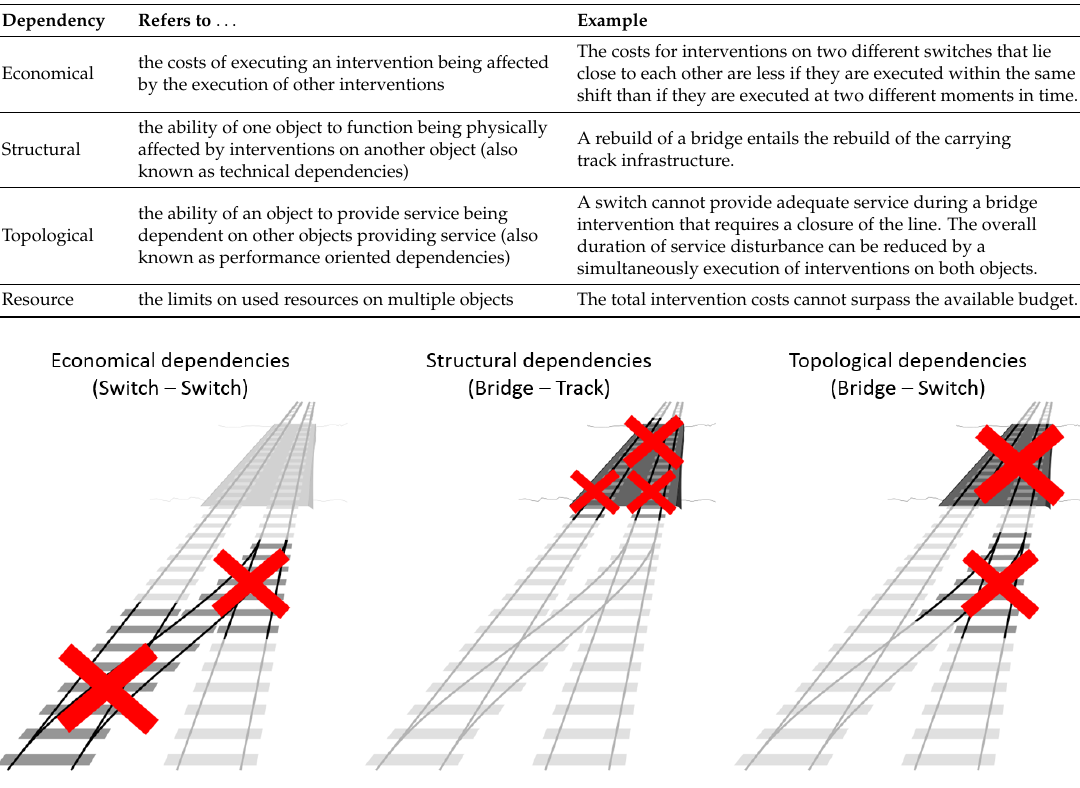
Figure 2. Economical, structural and topological dependencies.